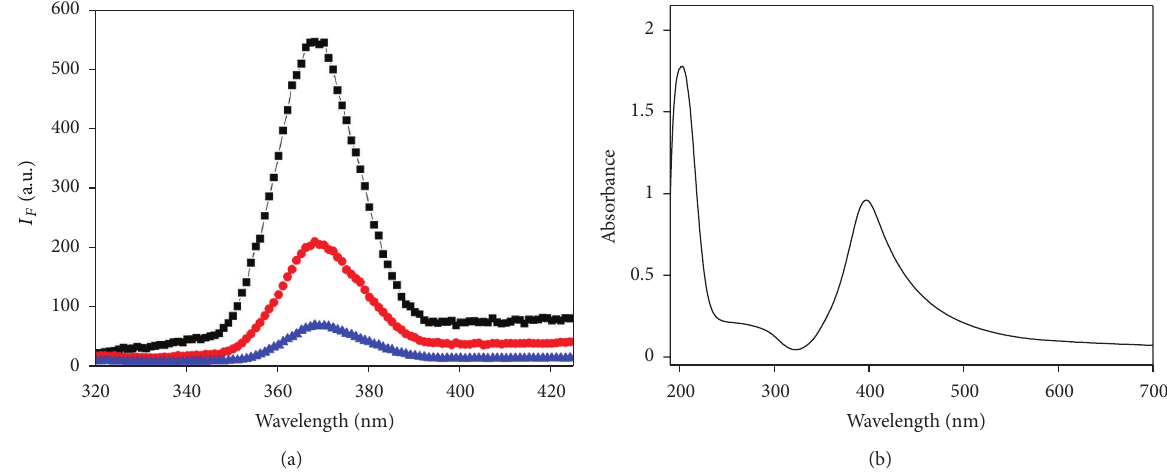
Figure 2: (a) Fluorescence emission spectra of Ag NCs at 𝜆 respectively; (b) UV-visible absorption spectrum of Ag